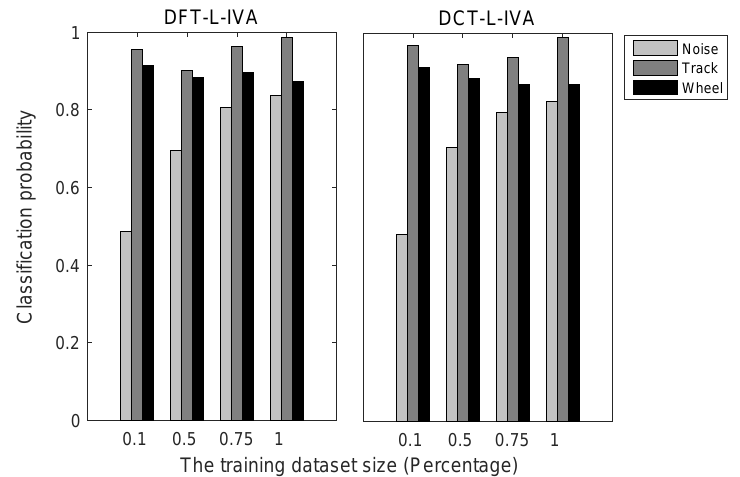
Figure 6. Classification probabilities of each target type using L-IVA on the training sets with different